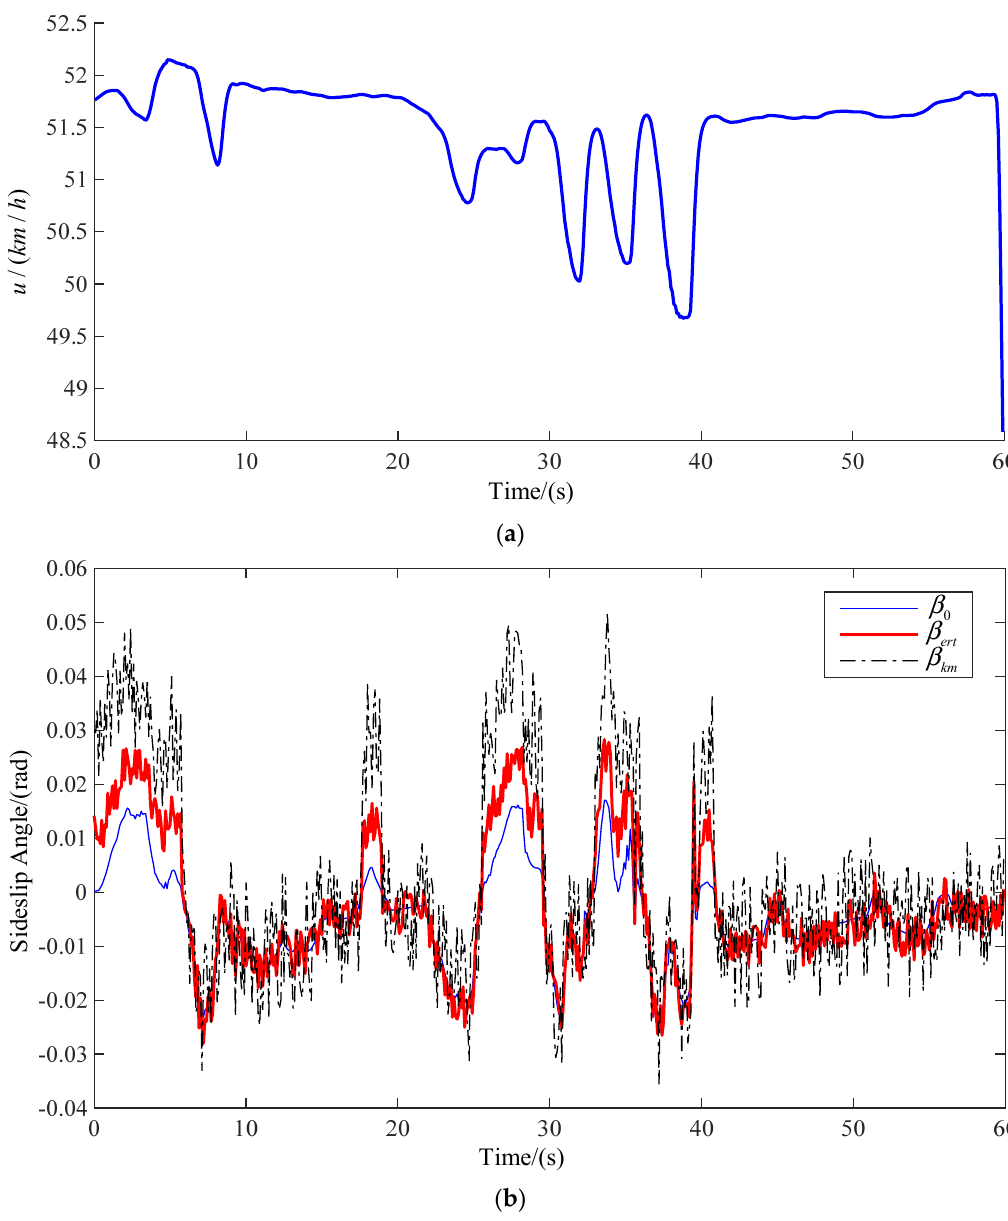
Figure 8. Medium and low speed ( a ) real − time speed; ( b ) estimation of sideslip angle.